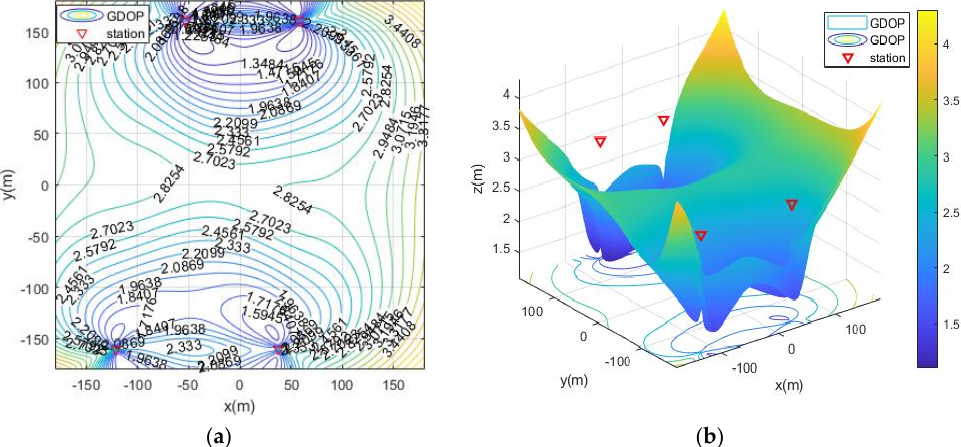
Figure 8. GDOP contour map of optimization results with 4 base stations located on both sides of the positioning area. ( a ) 2D contour map of moa02; ( b ) 3D contour map of moa02.